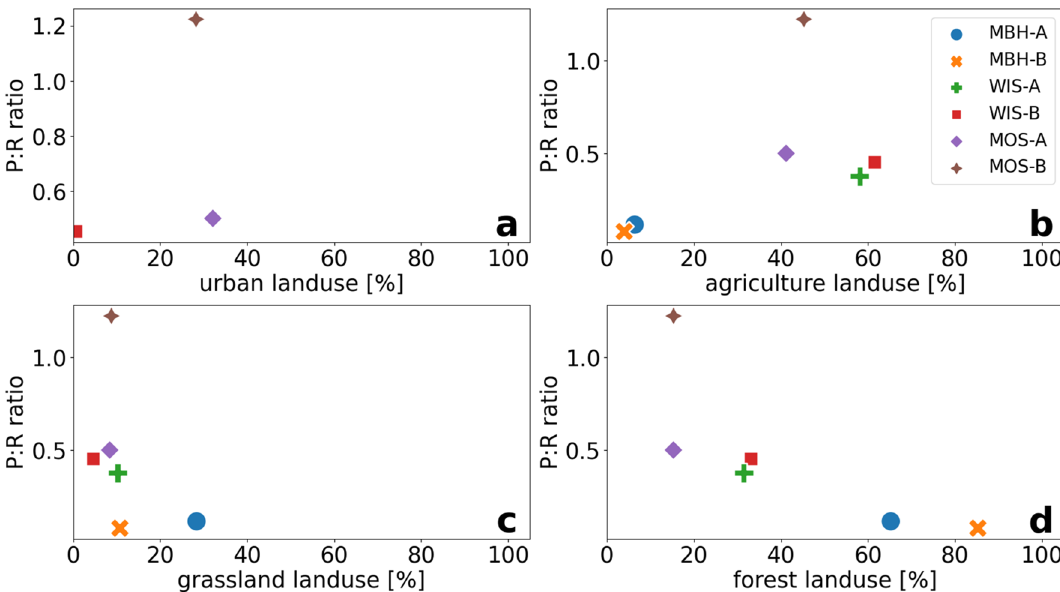
Figure 4. Land use type proportions in relation to modelled midnight-to-midnight photosynthesis to respiration (P:R) ratios within the catchments of the respective upstream (A) and downstream (B) sampling sites at the streams Mähringsbach (MBH), Wiesent (WIS) and Moosach (MOS). Shown land use types are urban ( a ), agriculture ( b ), grassland ( c ) and forest ( d